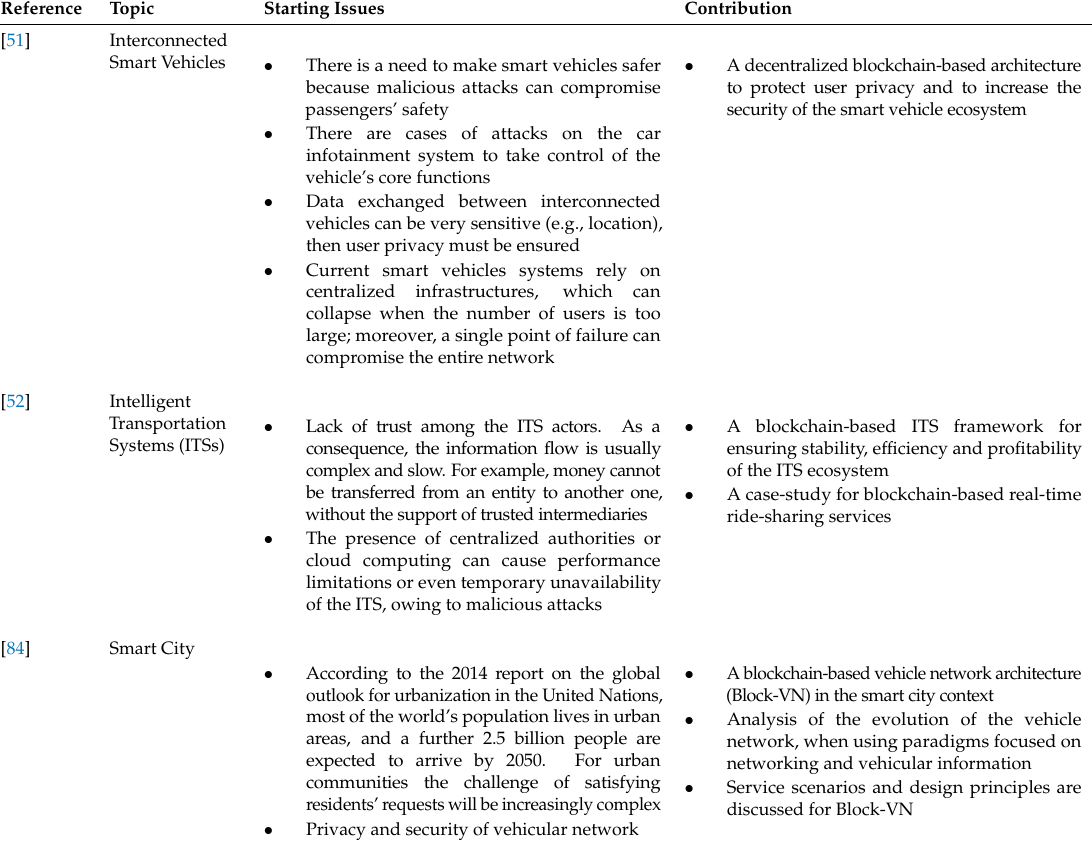
Table 8. Analysis of the most relevant documents belonging to C 2 (part